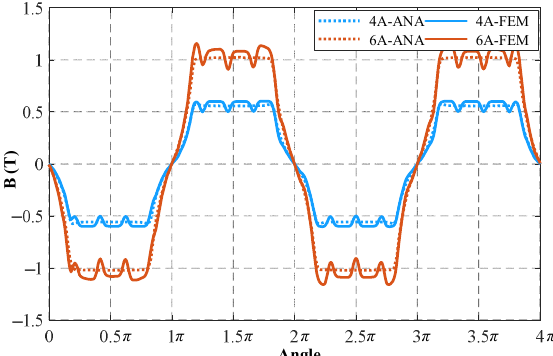
Figure 14. No-load magnetic field distribution of the axial and radial views.